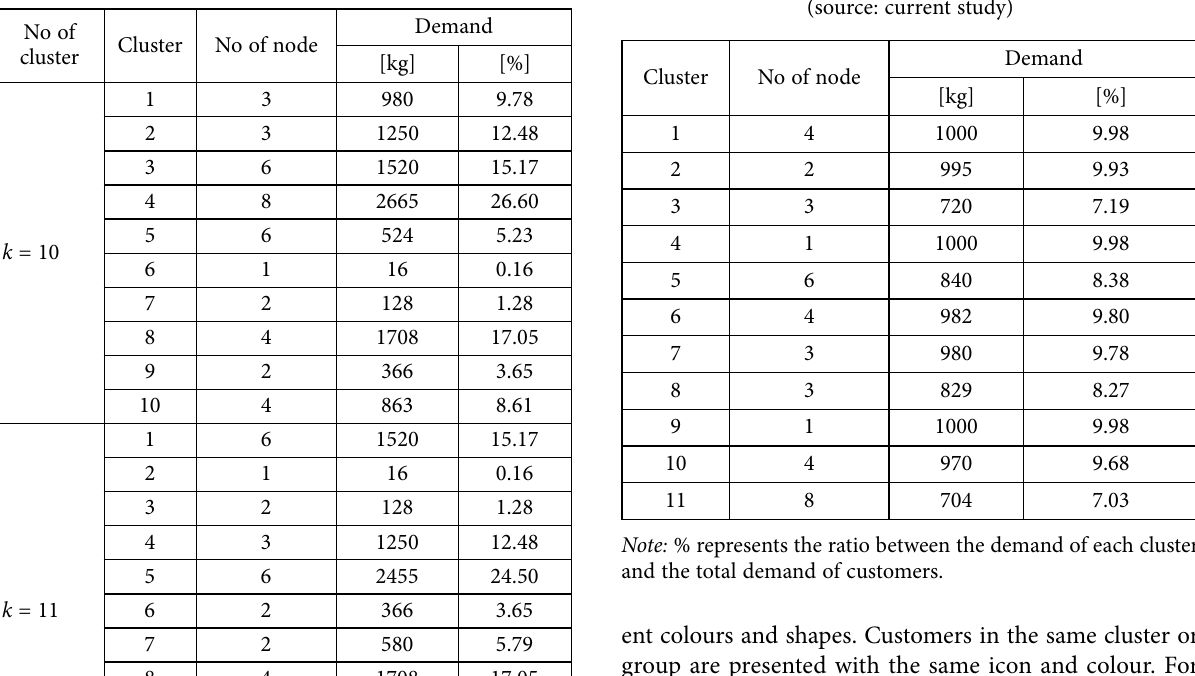
Table 4. Capacitated k -means clustering